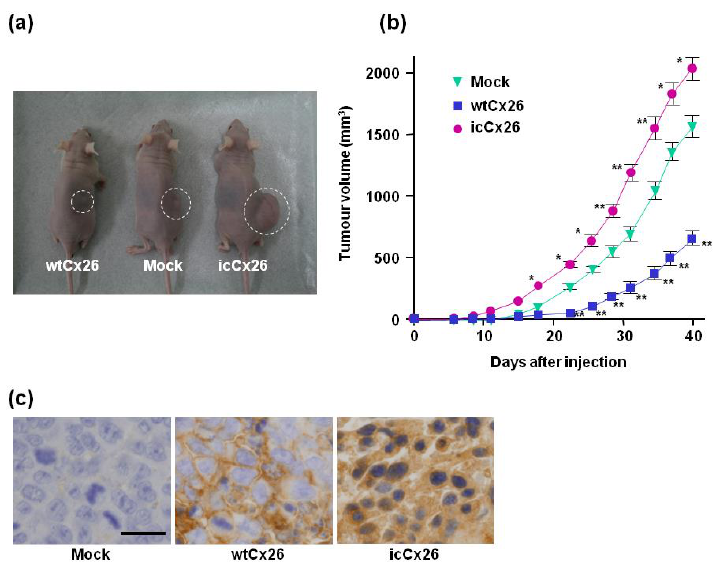
Figure 4. Xenografts of the wtCx26, icCx26, and mock clones into nude mice and tumorigenicity assay in vivo. ( a ) Representative mice bearing tumours raised from 1 × 10 6 cells of each clone. ( b ) Tumorigenicity in vivo of each clone. The size of each tumour was measured every 2 or 3 days. Error bars represent the SD ( n = 6). No error bar is indicated when the SD is too small to show. * p < 0.03, ** p < 0.001 (significantly different from the mock clone at the corresponding time point). ( c ) Expression and subcellular localisation of Cx26 protein in the tumours raised from the xenografts. As revealed by immnohistochemistry, wtCx26 was localised in a cell-cell boundary area. Scale bar, 20 µm.